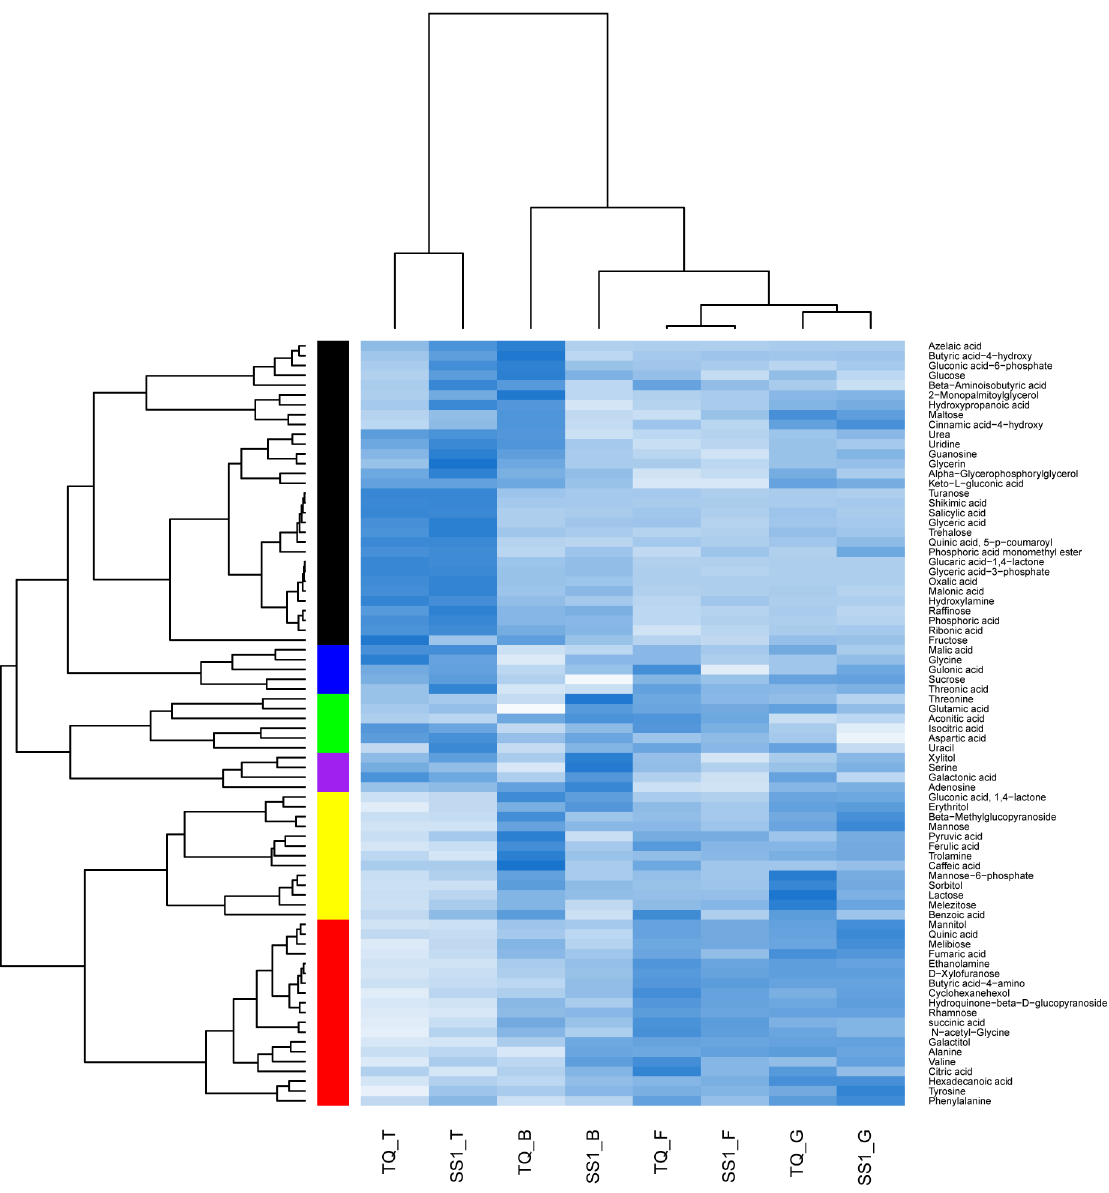
Fig 2. Hierarchical clustering analysis of the metabolite levels in leaves of Teqing (TQ) and NIL- SS1 ( SS1 ) at tillering (T), booting(B), flowering (F) and grain filling (G) stages using the R